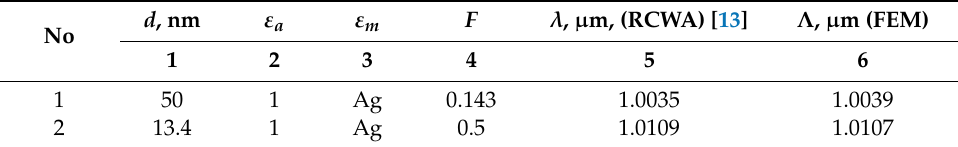
Table 1. Parameters of periodic structures for silver substrate according to Figure 1a, and the resonant wavelengths determined by Rigorous Coupled Wave Analysis (RCWA) and finite element method (FEM). The grating period is 1 µ m for all examples in Table 1.